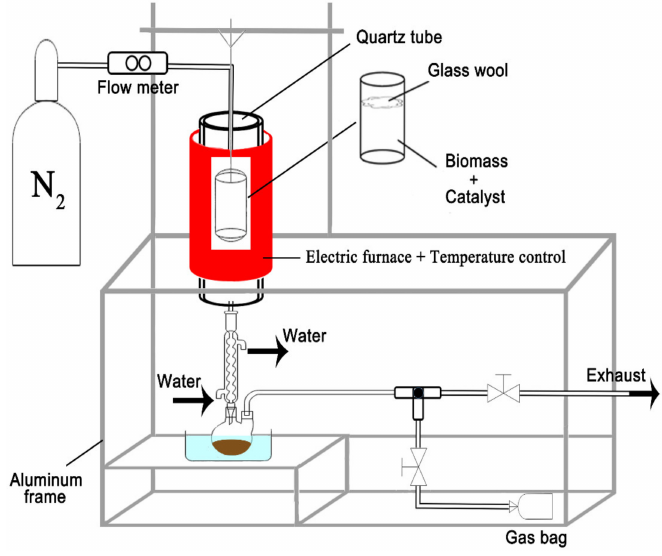
Figure 11. Experimental set-up for pyrolysis